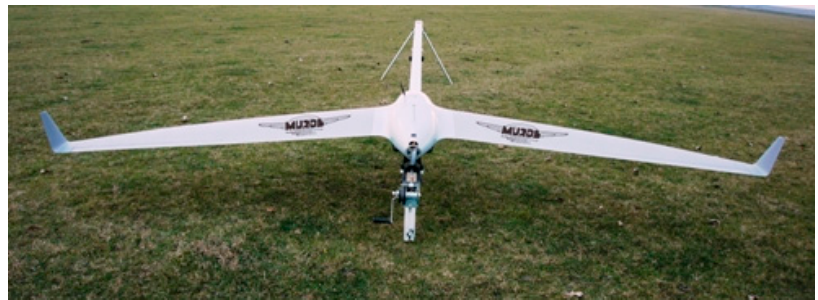
Figure 2. UAV MUROS on launcher.